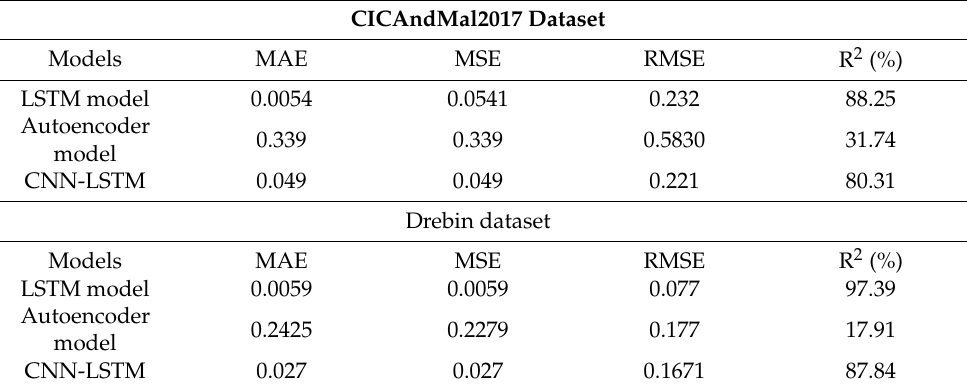
Table 12. Statistical analysis of the deep learning